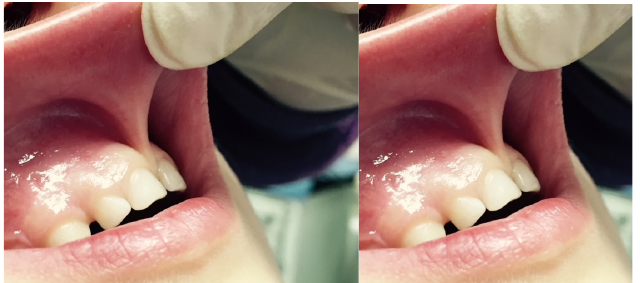
Figure 1. Example of the hypertonic ULF.